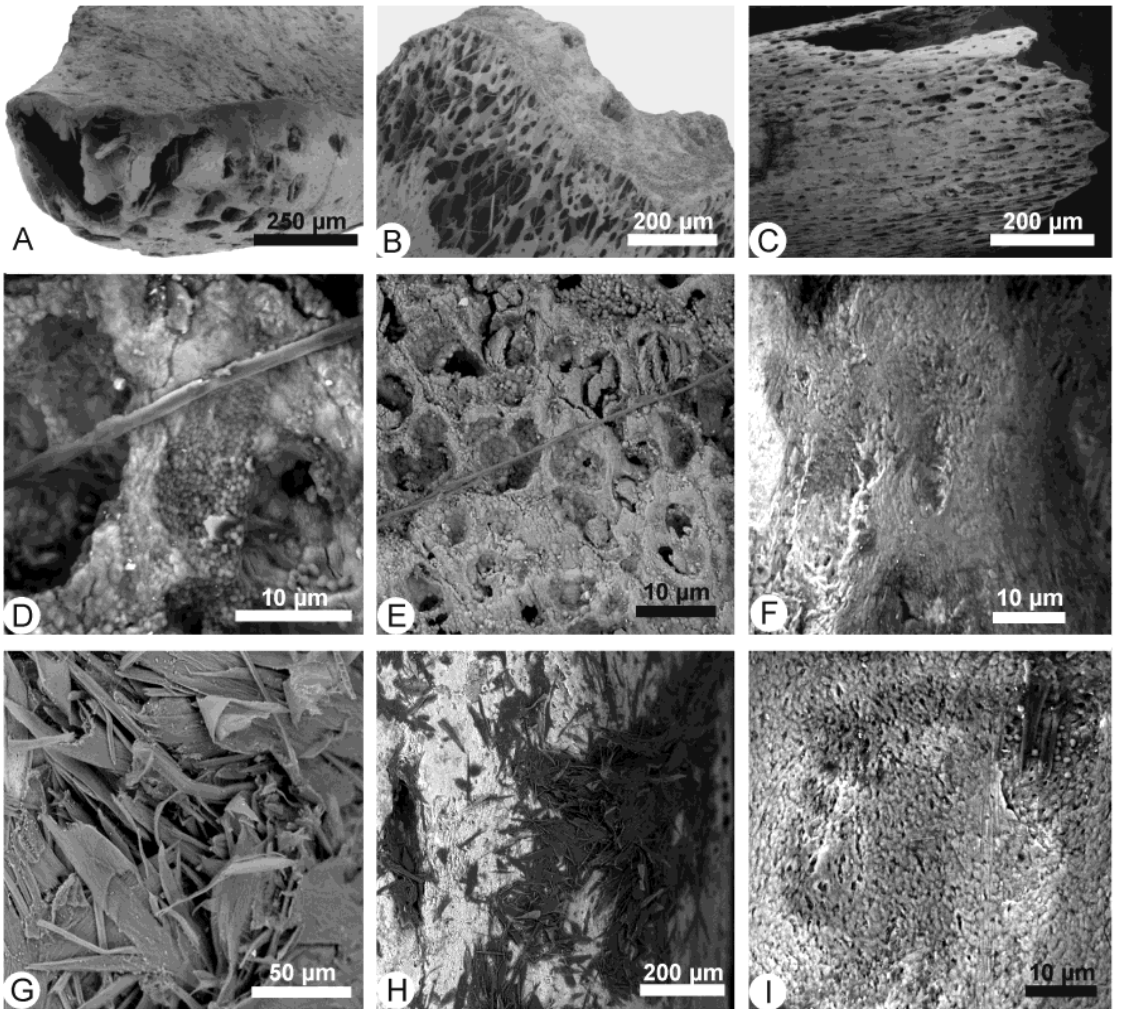
Figure 8. Murid rodent bones from Bubo bubo pellets. ( A ). Humerus distal epiphysis displaying